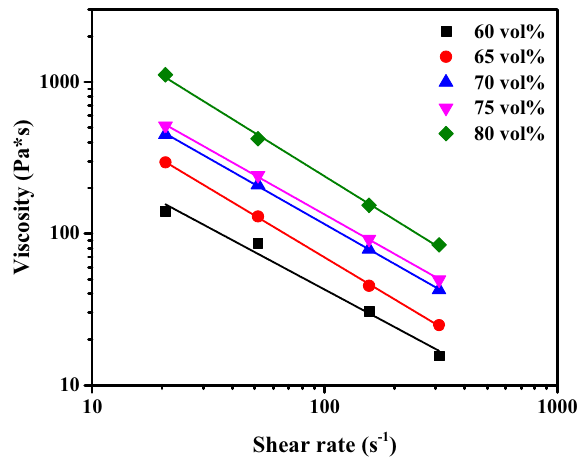
Figure 7. Relationship between the shear rate and viscosity of the trimodal feedstock with varying solid loadings.